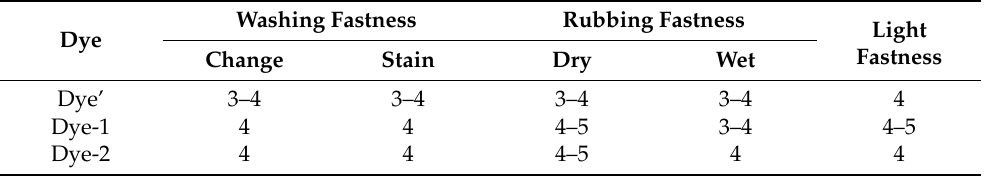
Table 3. Washing fastness, rubbing fastness, and light fastness of dyed cotton